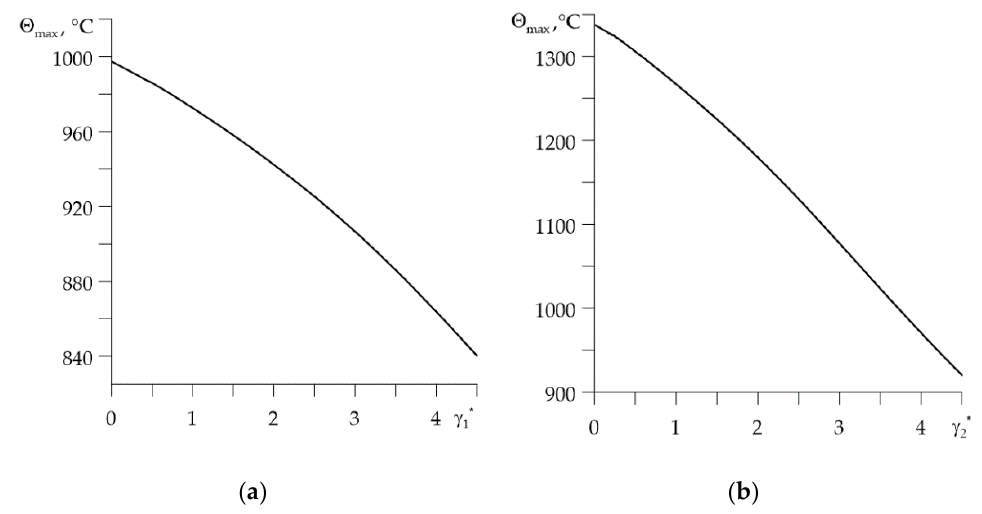
 at s5.0 = t on the dimensionless max i = for γ ∗ 2 1